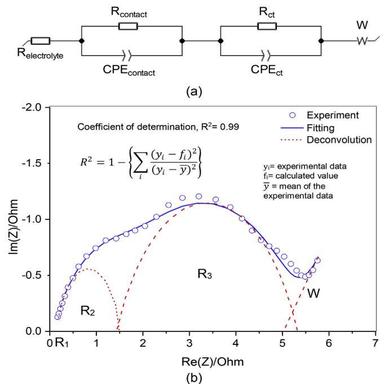
Modified equivalent circuit used to fit the EIS experimental data (a), and deconvolution of Nyquist impedance plot for 50% SoC of AB1.9 annealed alloy achieved by using a superposition of equivalent circuits, where R1 ¼ Relectrolyte, R2 ¼ Rcontact, R3 ¼ Rct, and W ¼ Warburg element (b). Successful deconvolution result was shown by the coefficient of determination (R2 ) value of 0.99, or close to 1.